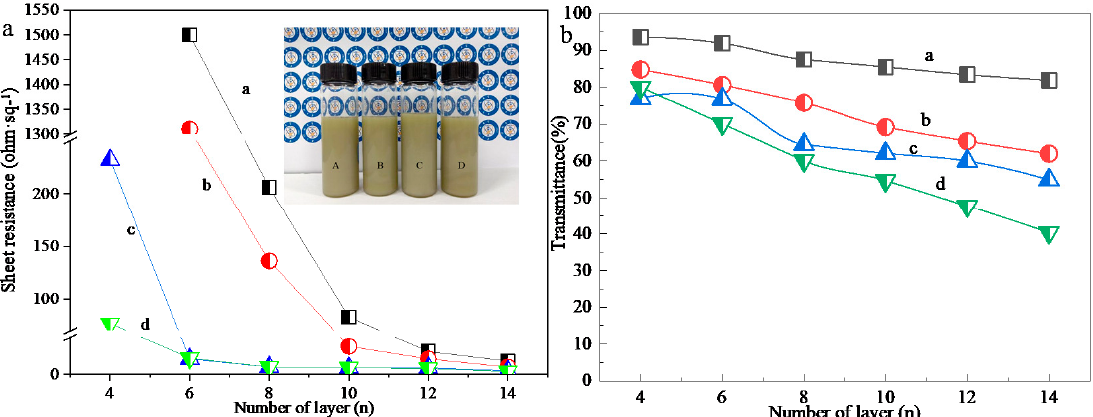
Figure 7. ( a ) Sheet resistances and ( b ) optical transmittance spectra of the samples with concentrations of 0.38 (curve a), 0.57 (curve b), 0.74 (curve c), and 0.91 mg ∙ mL − 1 (curve d). The insert is a photograph of AgNWs inks with concentrations of 0.38 (A), 0.57 (B), 0.74 (C), and 0.91 mg ∙ mL − 1 (D).